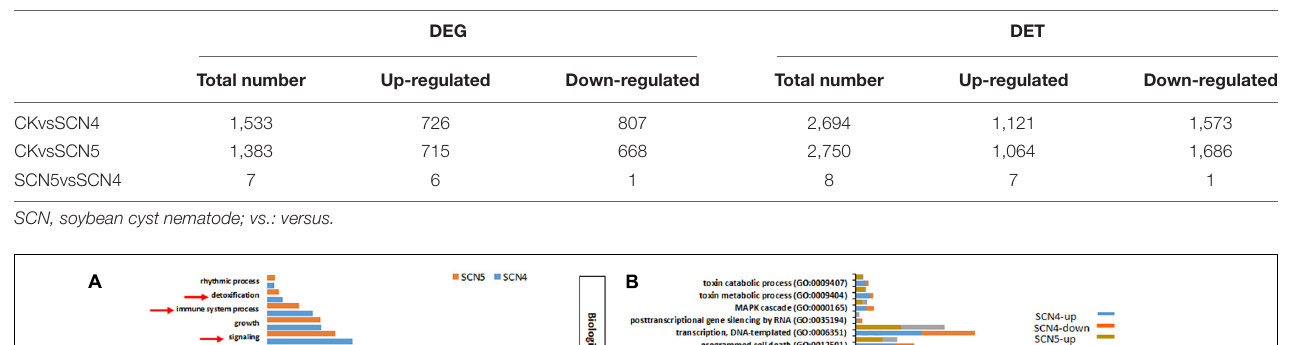
TABLE 2 | Number of differentially expressed genes (DEGs) and transcripts (DETs) between un-infected (CK) and Heterodera glycines -infected treatments (SCN4 and SCN5), and between SCN5 and SCN4.